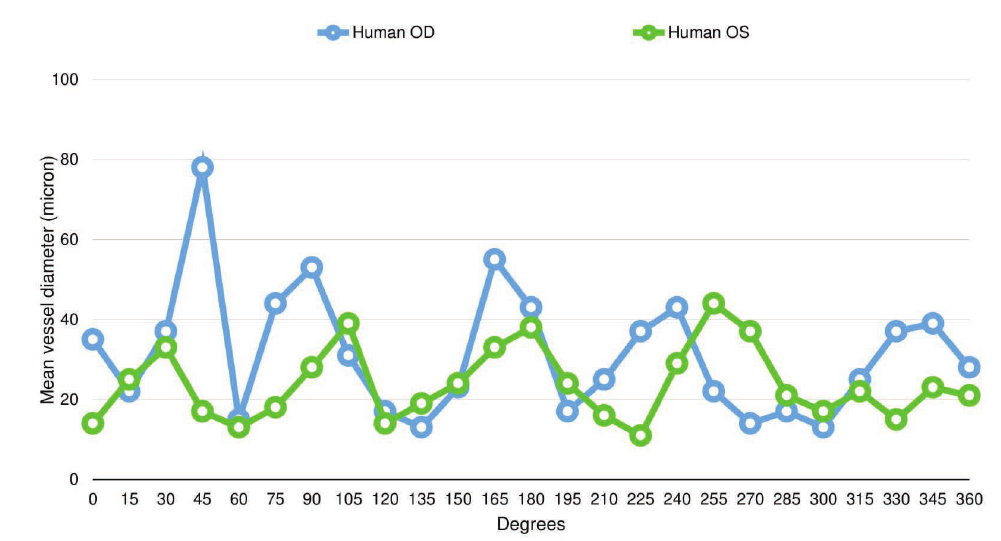
Figure 6. Episcleral vessel diameter distribution along the limbal perimeter in human eyes. Larger-diameter episcleral vessels appear to group in clusters that span 40–50 o